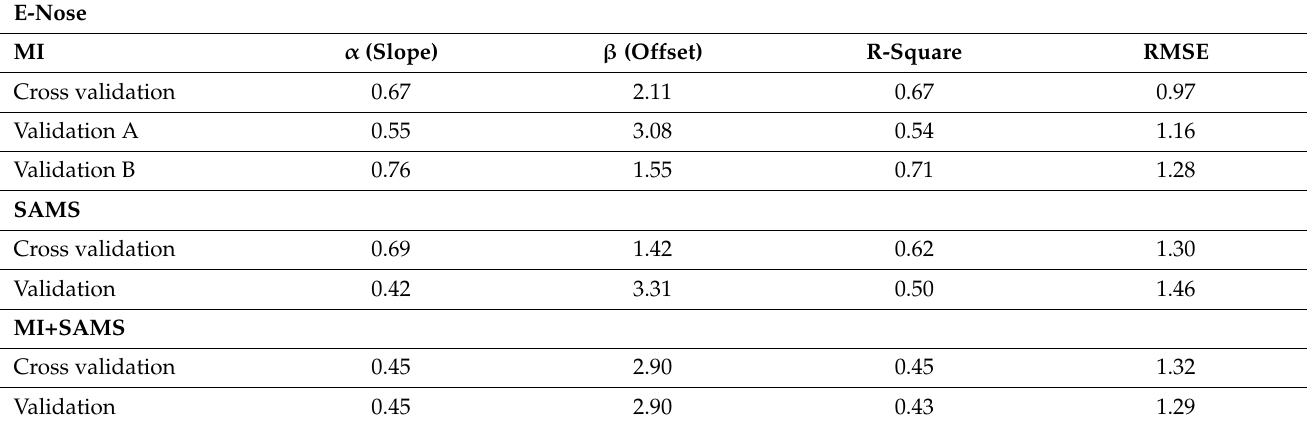
Table 5. Linear regression fit parameters between actual and predicted TVC values for the different